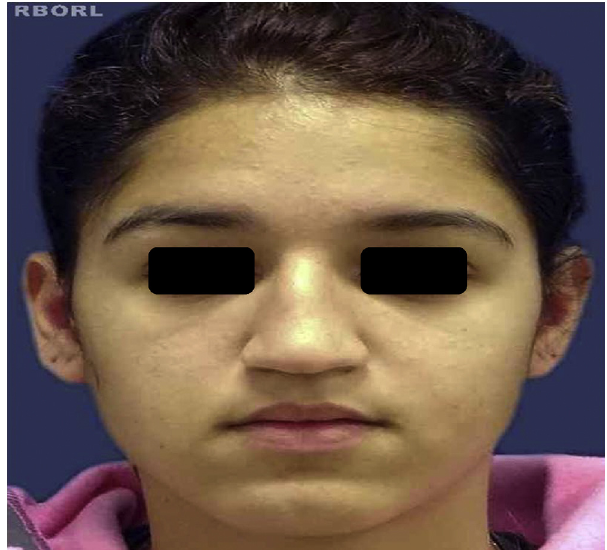
Figure 3 Preoperative nasal base picture.